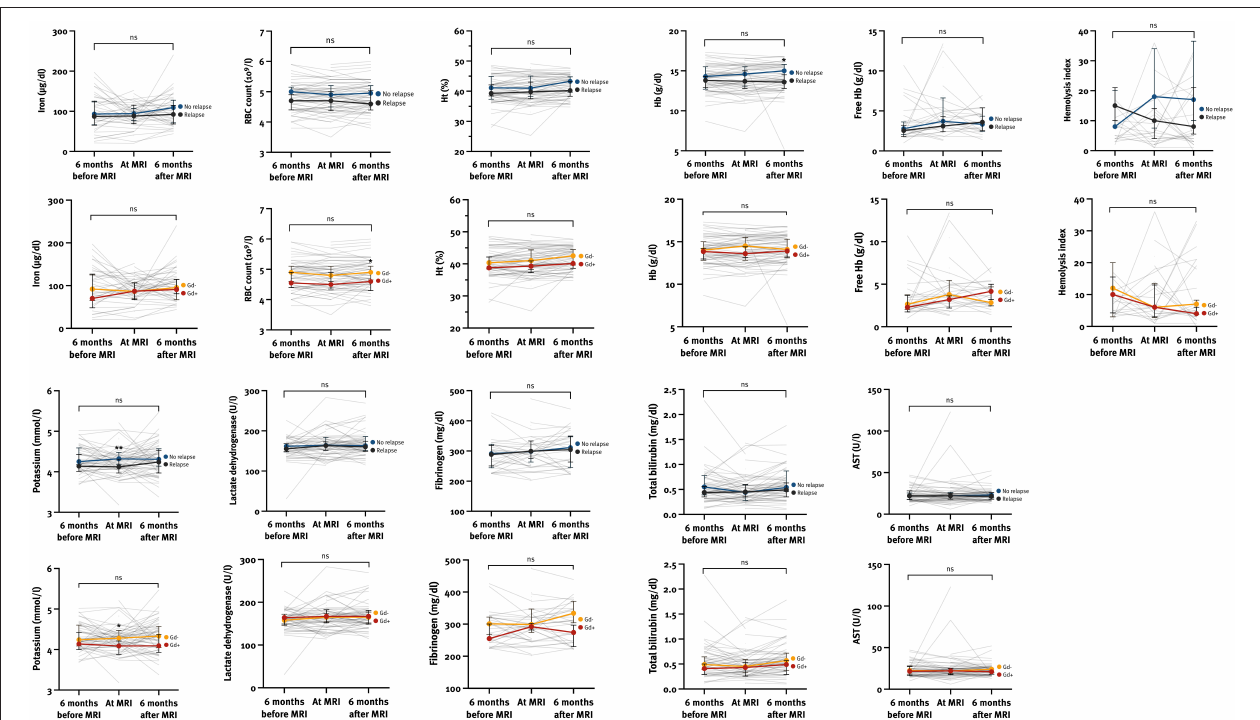
FIGURE 3 | The variability of hemolysis parameters at different time points according to the clinical and radiological activity within the observation period. AST, aspartate transaminase; Gd, gadolinium-enhancing lesion; Ht, hematocrit; Hb, hemoglobin; ns, not significant; RBC, red blood cells. * p < 0.05, ** p < 0.01 calculated by Mann-Whitney U